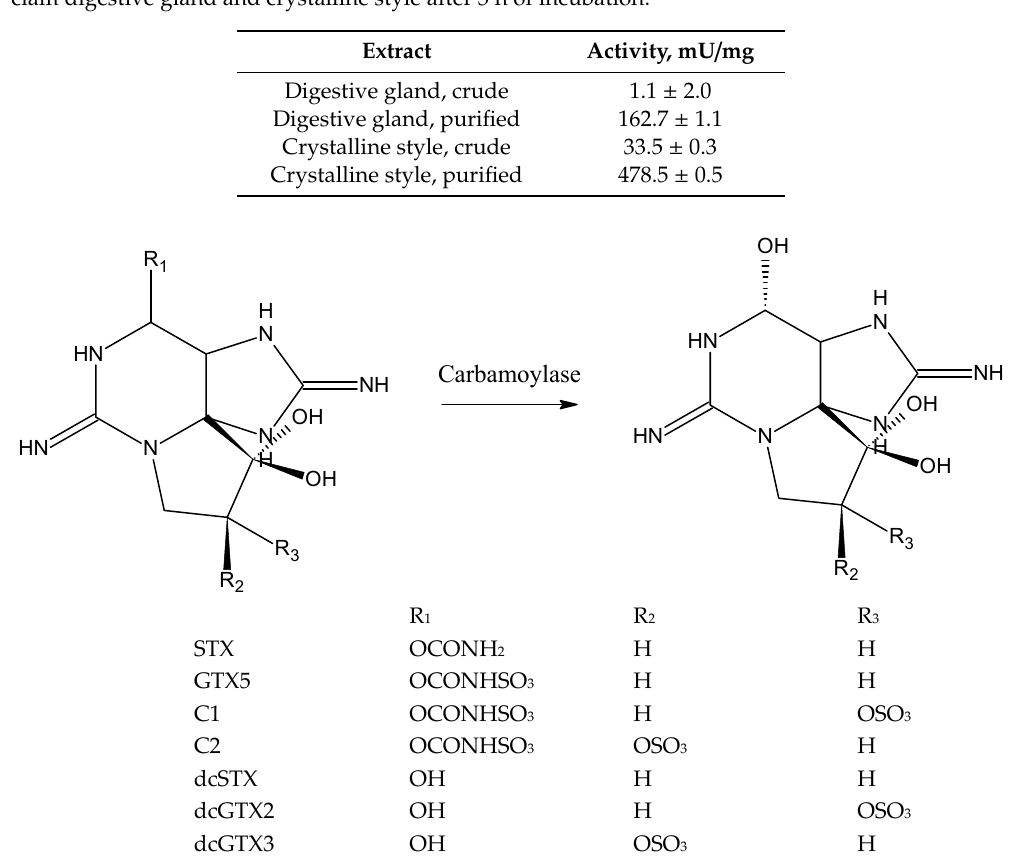
Figure 1. Reaction of carbamoylase with PSTs: Cleavage of carbamoyl or sulfocarbamoyl moiety (R1). The following transformation take place: STX → dcSTX, GTX5 → dcSTX, C1+2 → dcGTX2+3. Table 2. Specific enzymatic activity towards STX, C1+2 and GTX5 of carbamoylase purified from crystalline style of S. solida and substrate consumption (after 1 h of incubation).